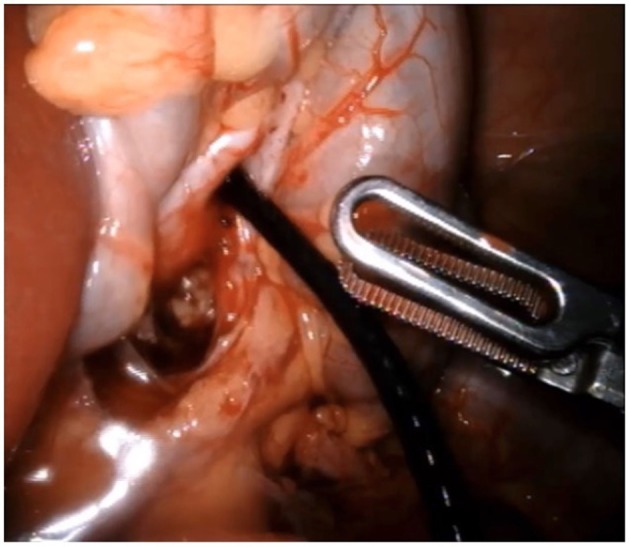
Nephroscopy using a standard digital flexible ureteroscope.